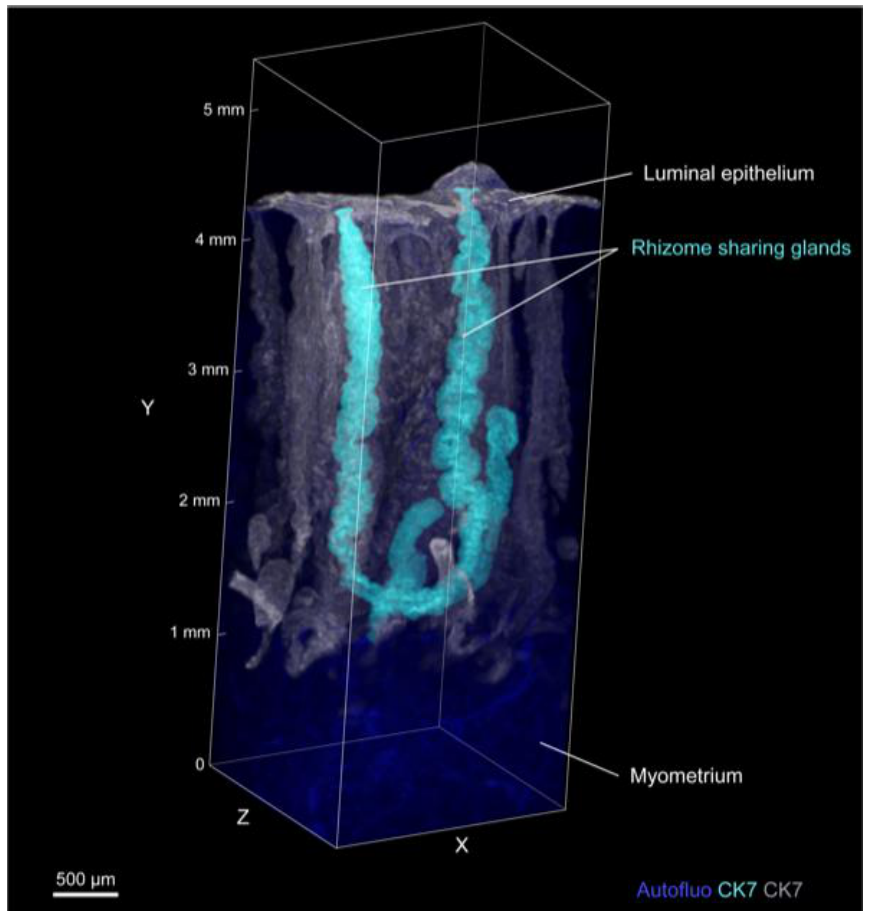
Figure 2. 3D morphology of the rhizome sharing glands (age 46, secretory phase). Three-dimensional reconstruction of the distribution of branched glands, which were pseudocolored and separated as new channels by the Surface module in Imaris [29]. Images were obtained by LSF microscopy. Autofluorescence was measured by excitation at 488 nm. CK7-expressing endometrial epithelial cells were measured by excitation at 532 nm. Autofluo, autofluorescence; CK7, cytokeratin 7. See also Video S1.